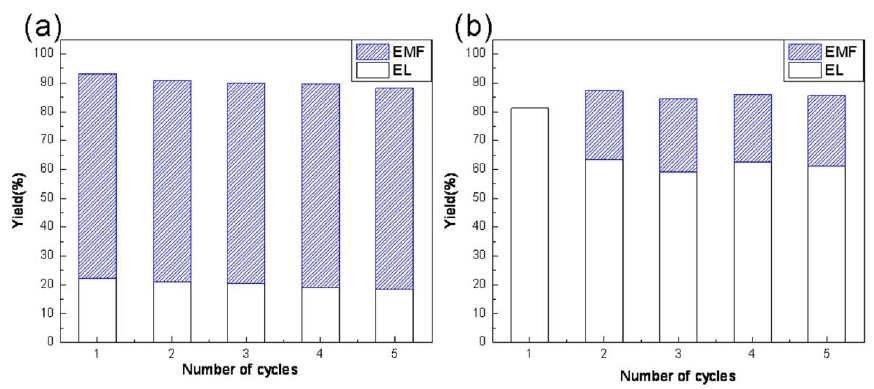
Figure 5. Catalyst recycling (reaction conditions: ( a ) 100 °C for 6 h, ( b ) 140 °C for 8 h).